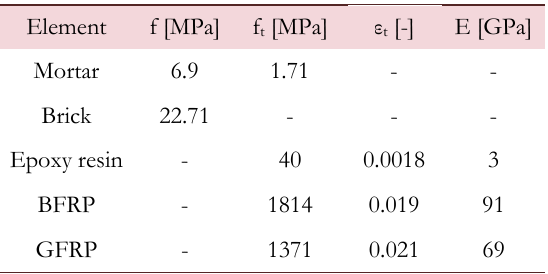
Table 2.A: Mechanical properties of constituents for the experimental tests [34].